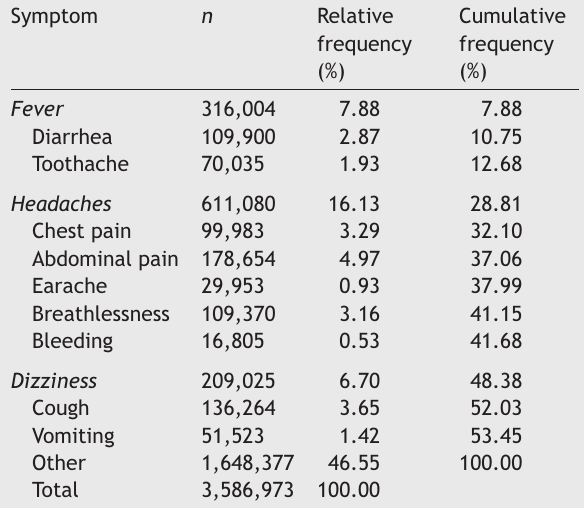
Population estimate of individuals interviewed in